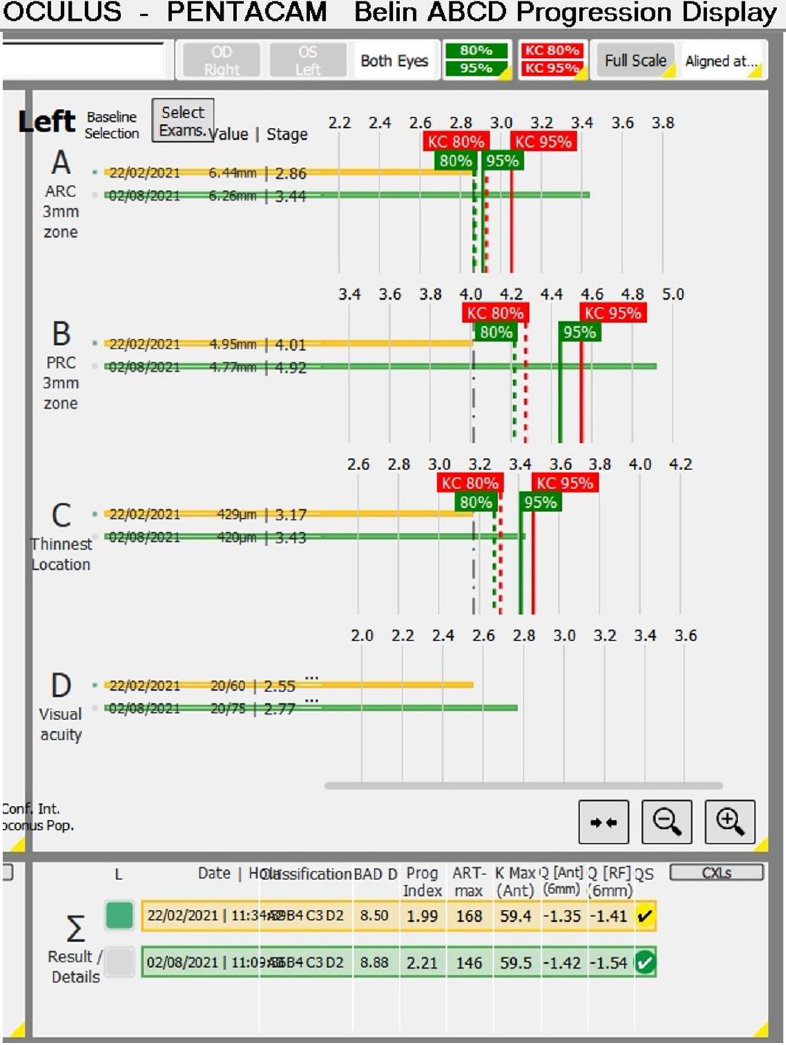
Figure 2. The Belin ABCD display shows progression in all parameters